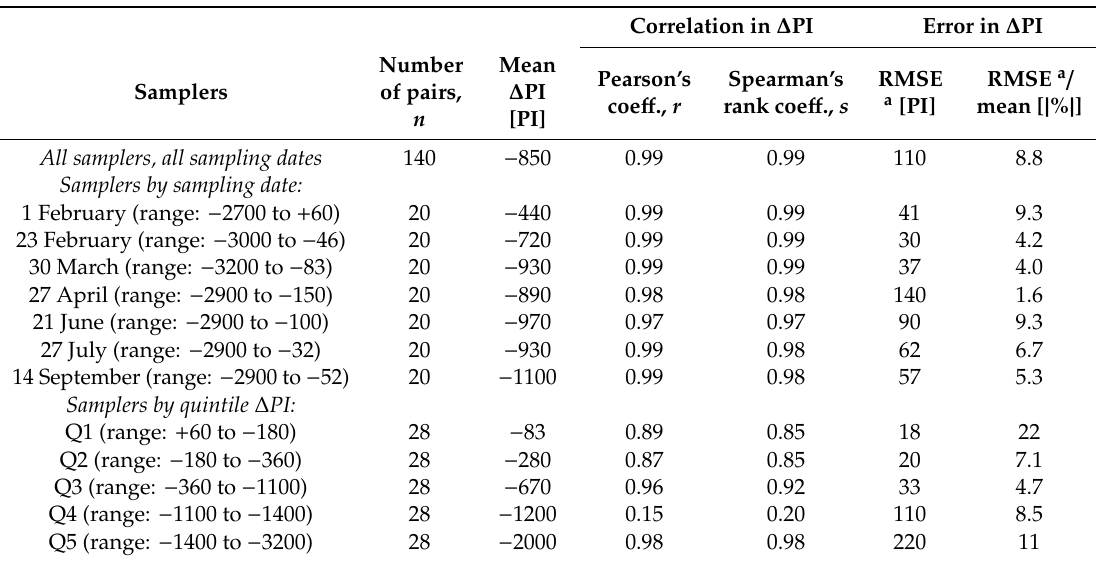
Table 2. Correlation and root mean square error (RMSE a ) in change in reflectance (change in mean pixel intensity ( ∆ PI)) between paired samplers in 20 indoor locations, by sampling date, and by quintile of change in reflectance ( ∆